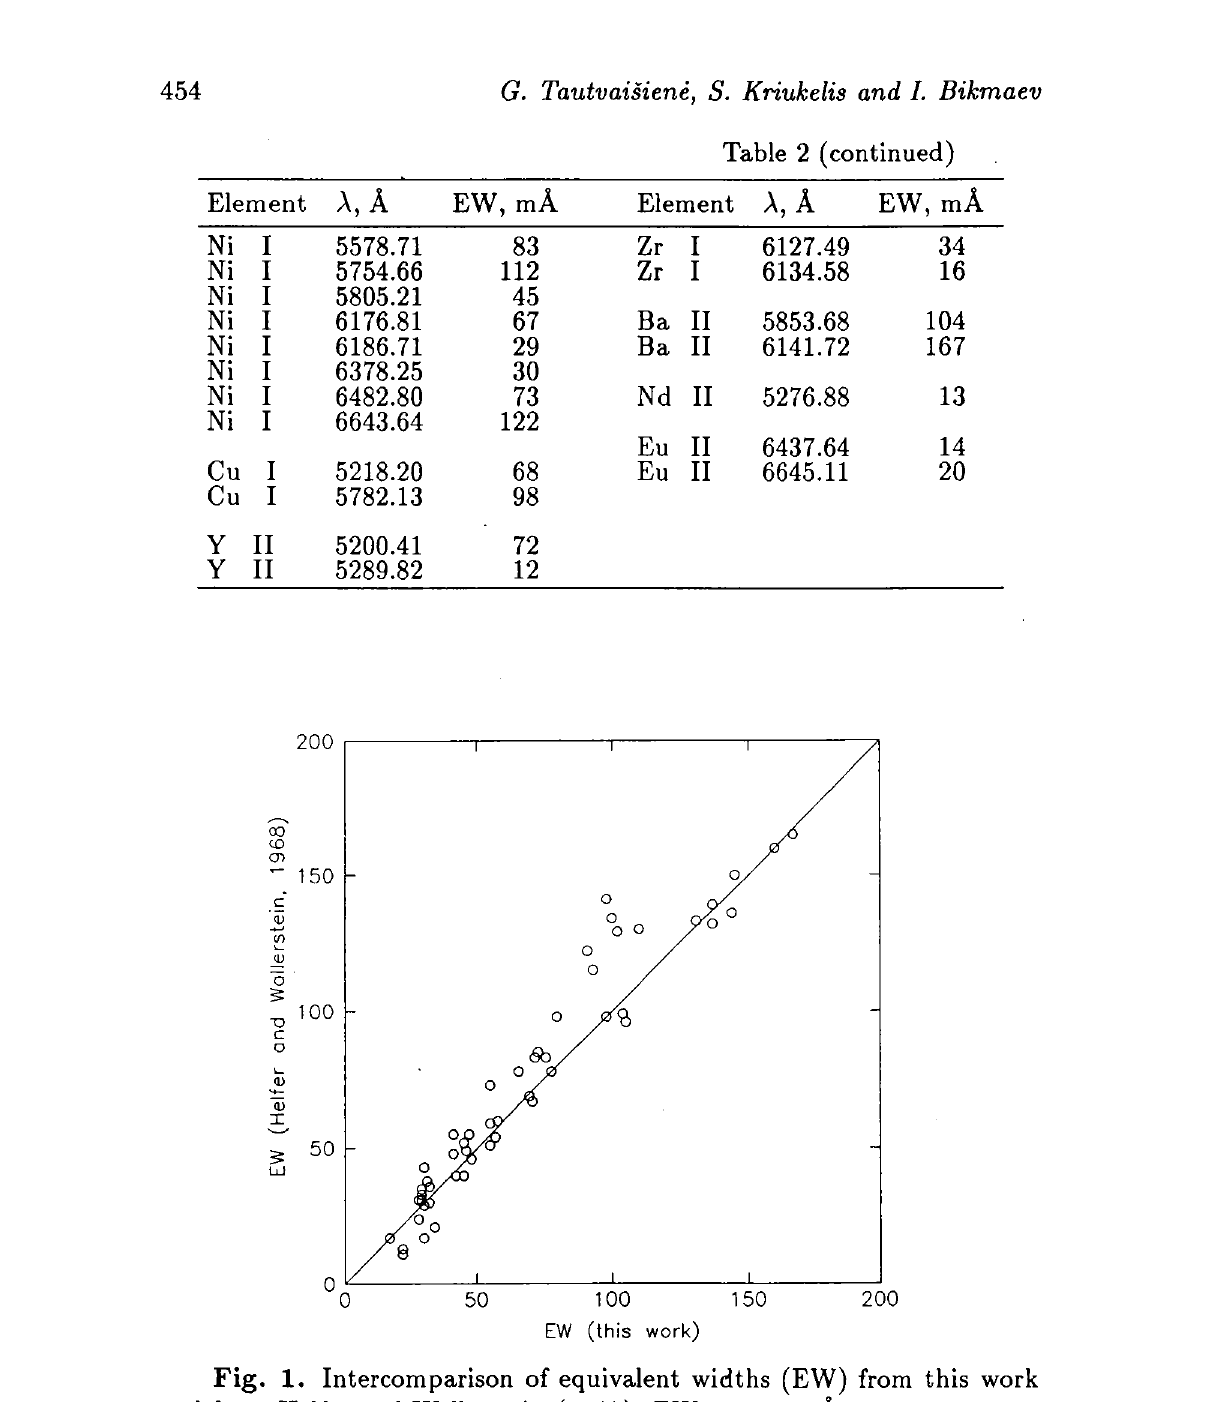
Fig. 1. Intercomparison of equivalent widths (EW) from this work and from Heifer and Wallerstein (1968). EWs are in